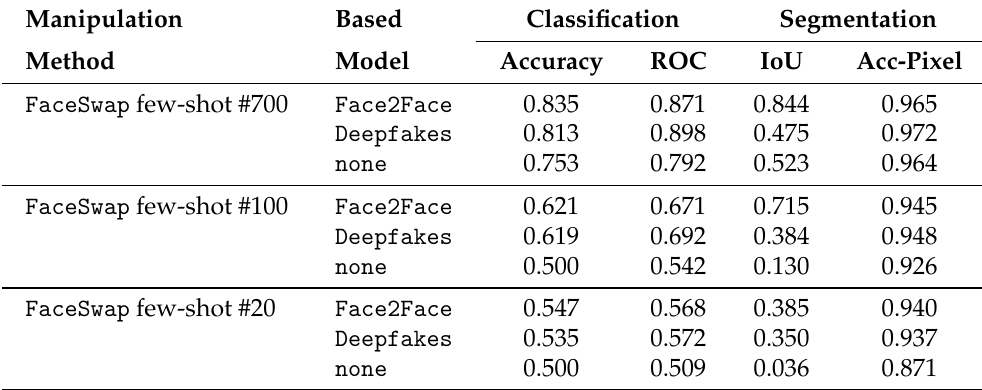
Table 4. Results for few-shot learning of detecting C23 crop images altered by FaceSwap manipulation methods with difference-based models. In this table, acc-pixel stands for pixel-wise accuracy.